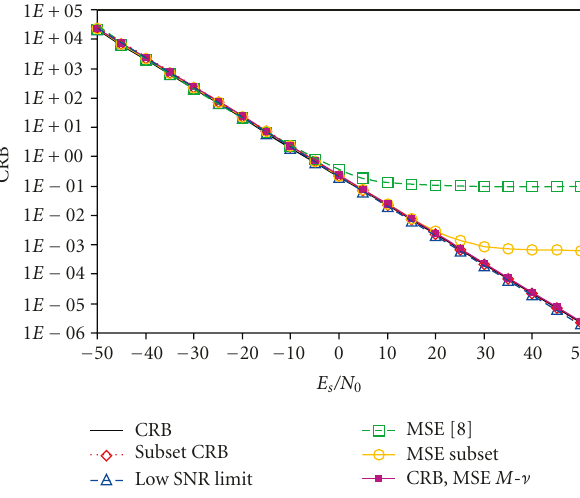
Figure 5: Influence of the guard interval length ν on the GCRB, M = 40, N = 1024.